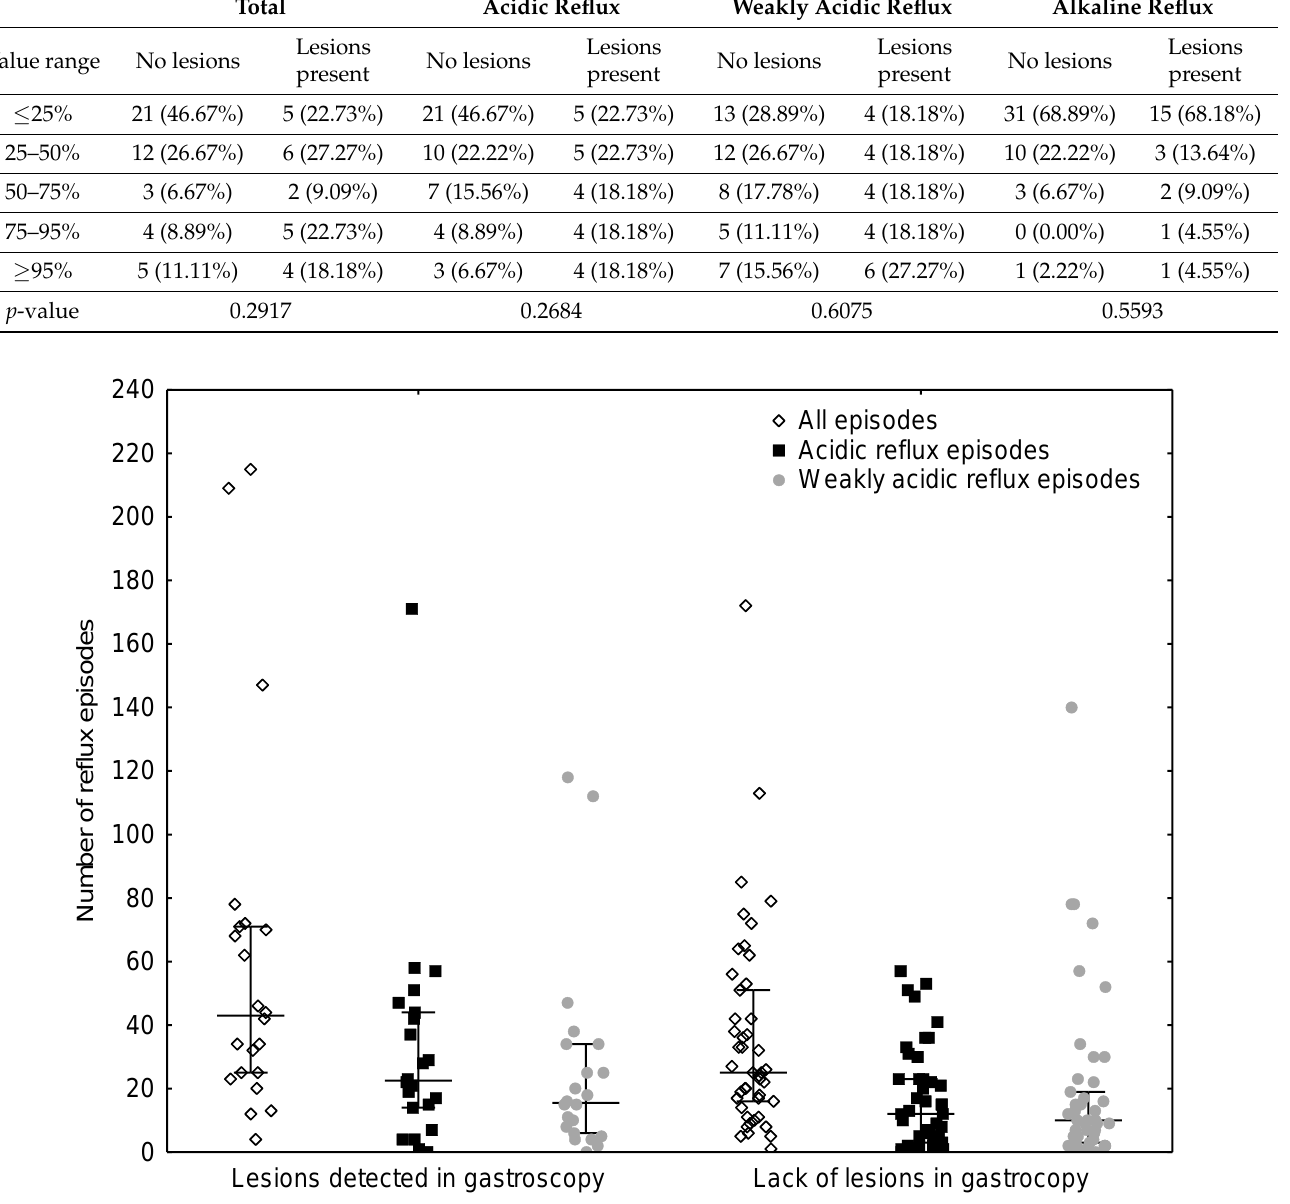
Table 4. Comparison of the numbers of different reflux episode types with (Hetzel–Dent II–IV) and without (Hetzel–Dent 0–I) detectable lesions in gastroscopy to the percentile ranges defined by Zerbib [4].